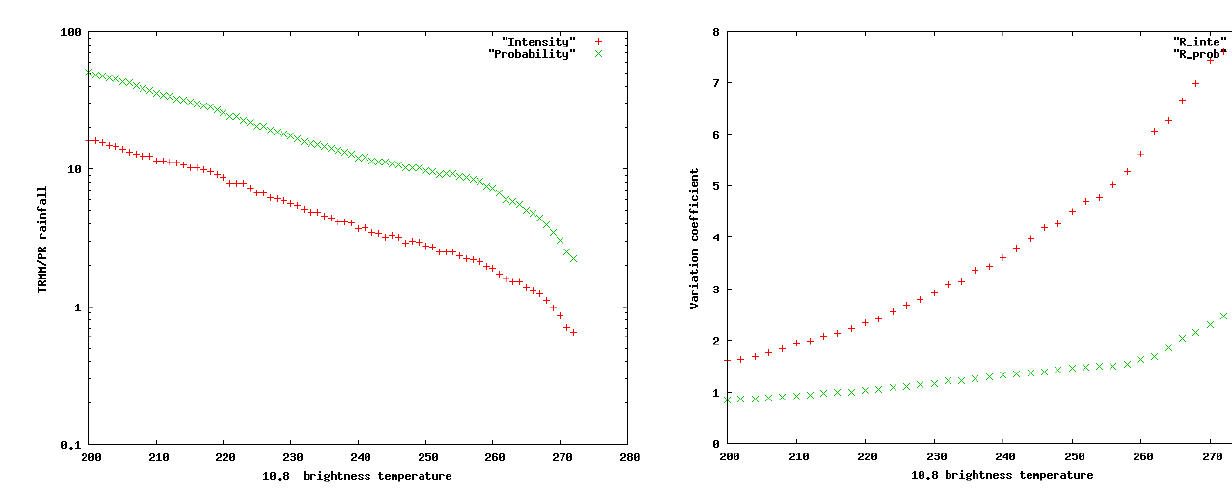
Fig. 1b. Variation coefficient for the rainfall intensity (red curve) Figure 1.b. Variation coefficient for the rainfall intensity (red curve) and the rainfall probability (green and the rainfall probability (green curve) versus 10.8µm brightness curve) versus 10.8 µm brightness temperature.